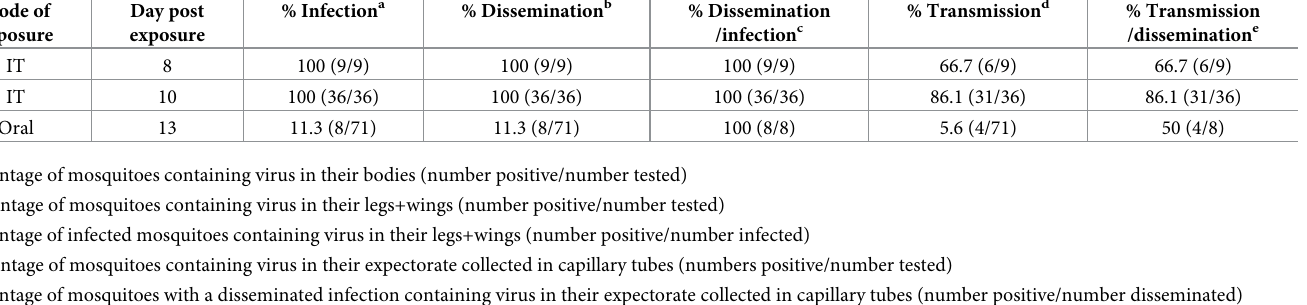
Table 2. Infection, dissemination and transmission rates of BgV in injected (IT) and bloodfed (oral) Cx . annulirostris mosquitoes. Mode of exposure